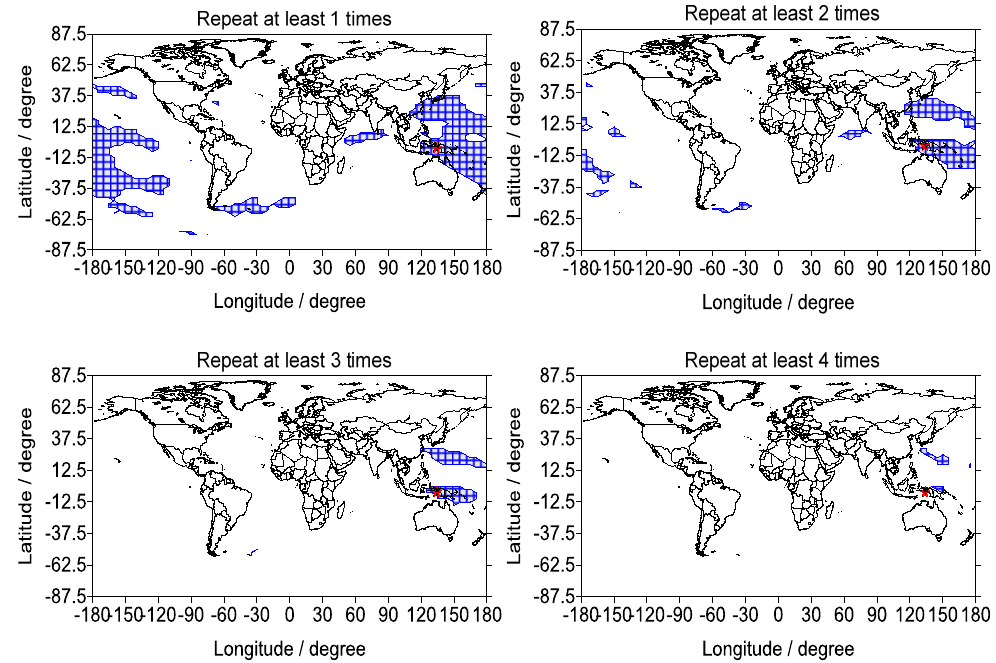
Fig. 17. Locations of the 30-day extreme enhancement that repeatedly appeared at various time points on 28 September 2010.